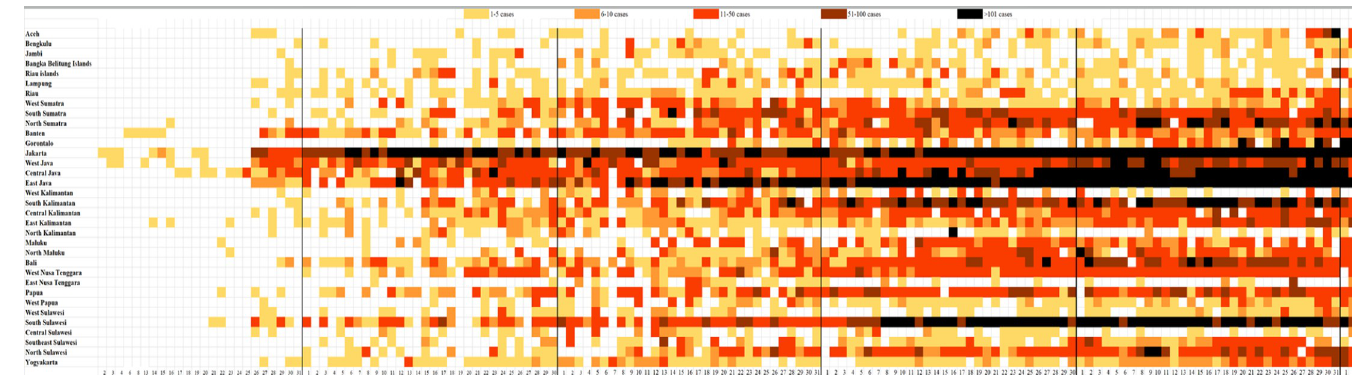
Fig 2. New confirmed cases per day in 34 provinces in Indonesia from March 2 nd –August 2 nd 2020.